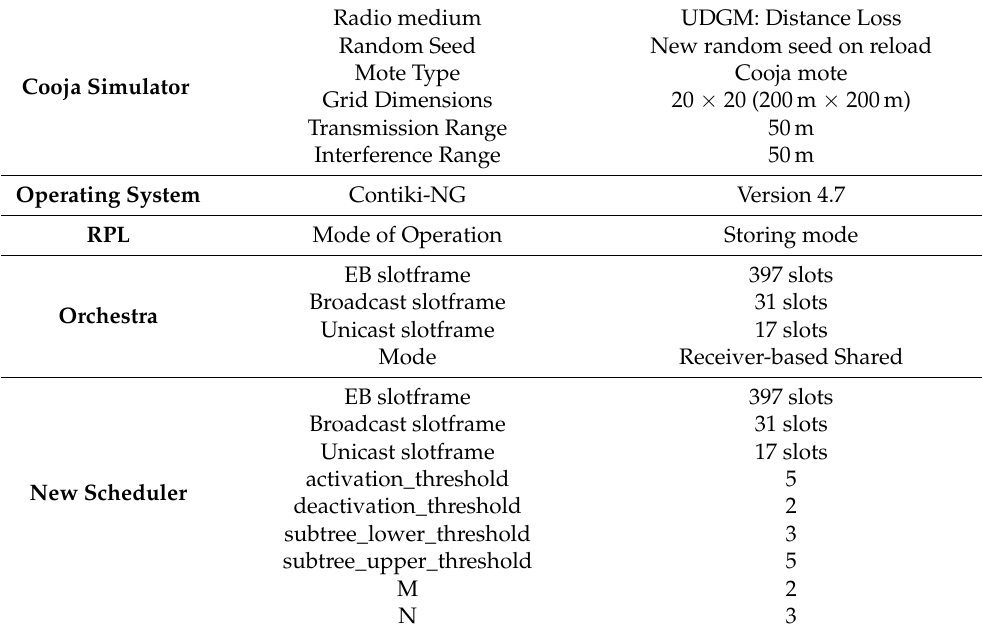
Table 3. Values for the parameters of the evaluation